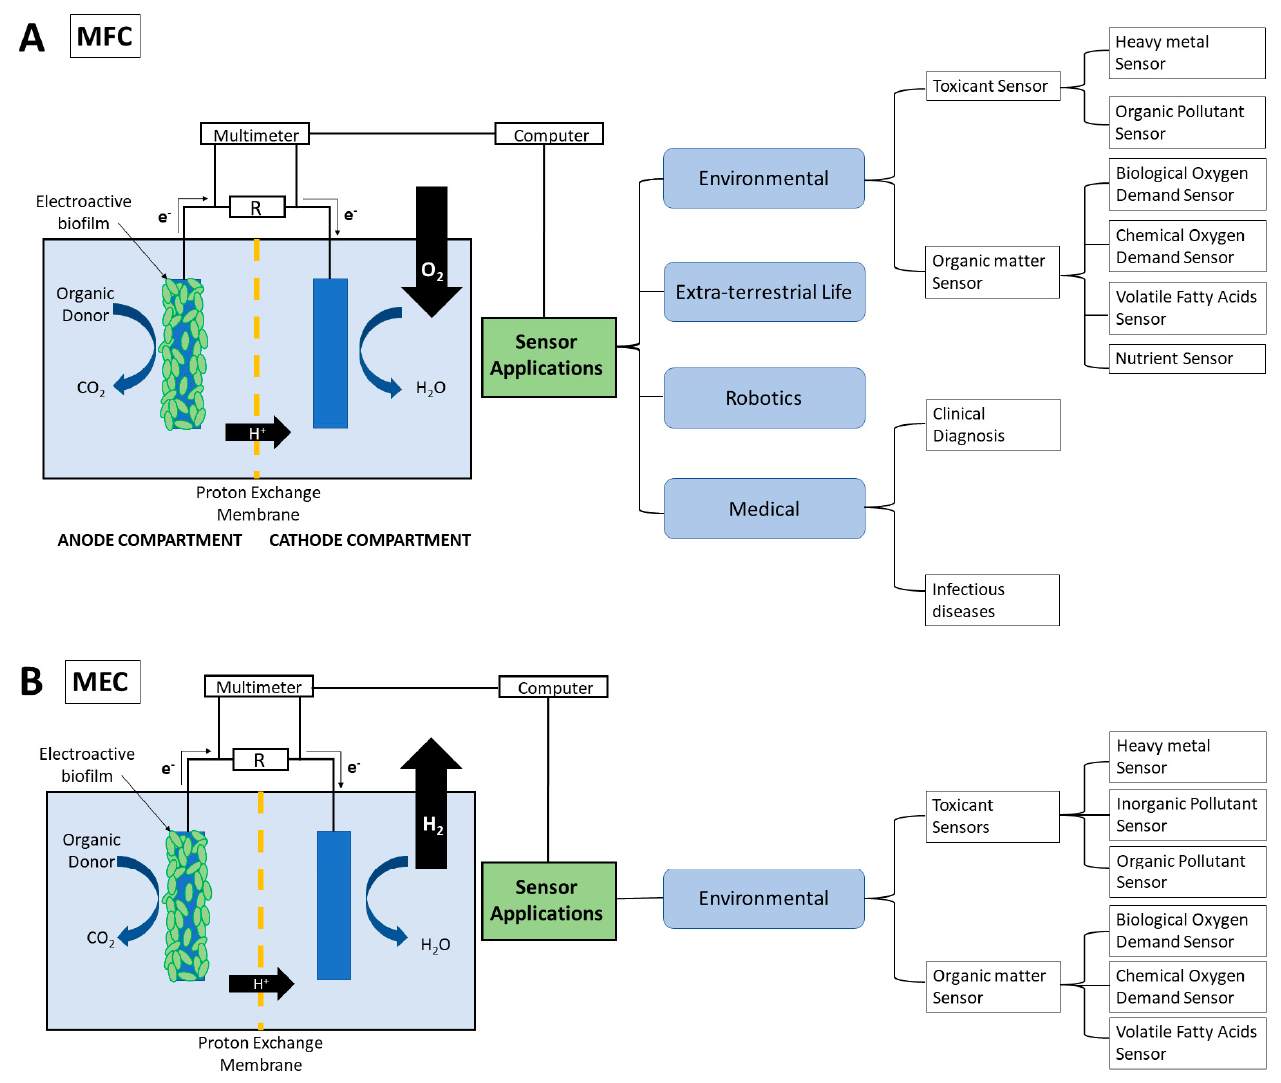
Figure 1. Schematic representation of the ( A ) microbial fuel cell and ( B ) microbial electrolysis cells and the anodic and cathodic reactions that occur. The sensor application of each MET type is also summarised.